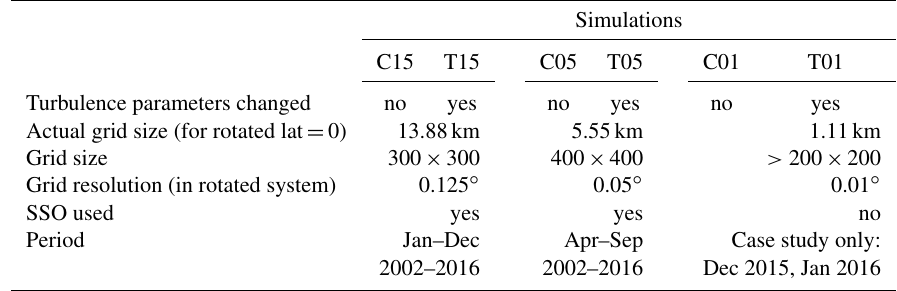
Table 1. Overview of the different simulations. The grid size for C01 and T01 was changed for each day with a minimal (maximal) size of 200 × 200 (353 ×